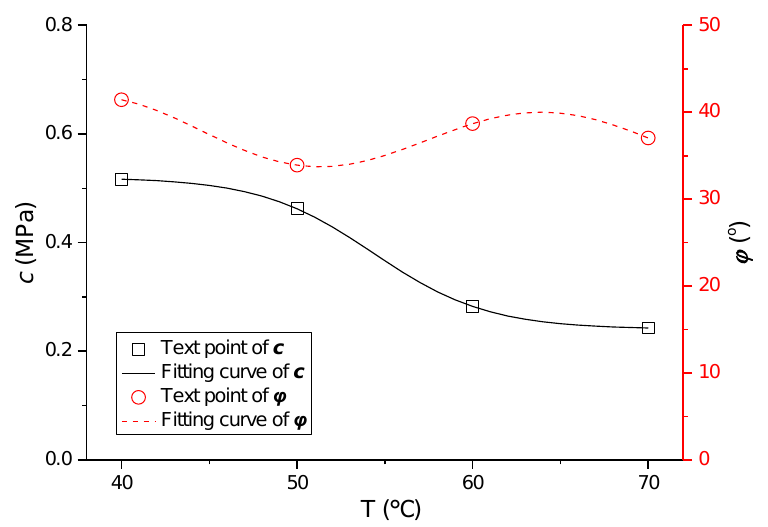
Figure 8. Fitting curve of shear parameters c and φ.